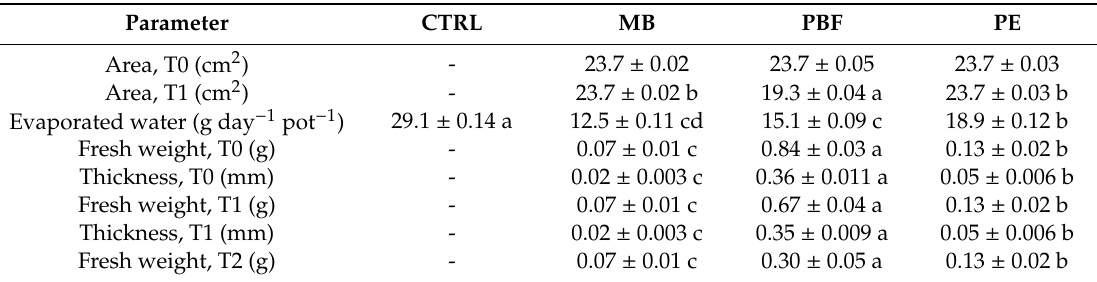
Table 1. The main characteristics of the assessed films during the pot experiment.